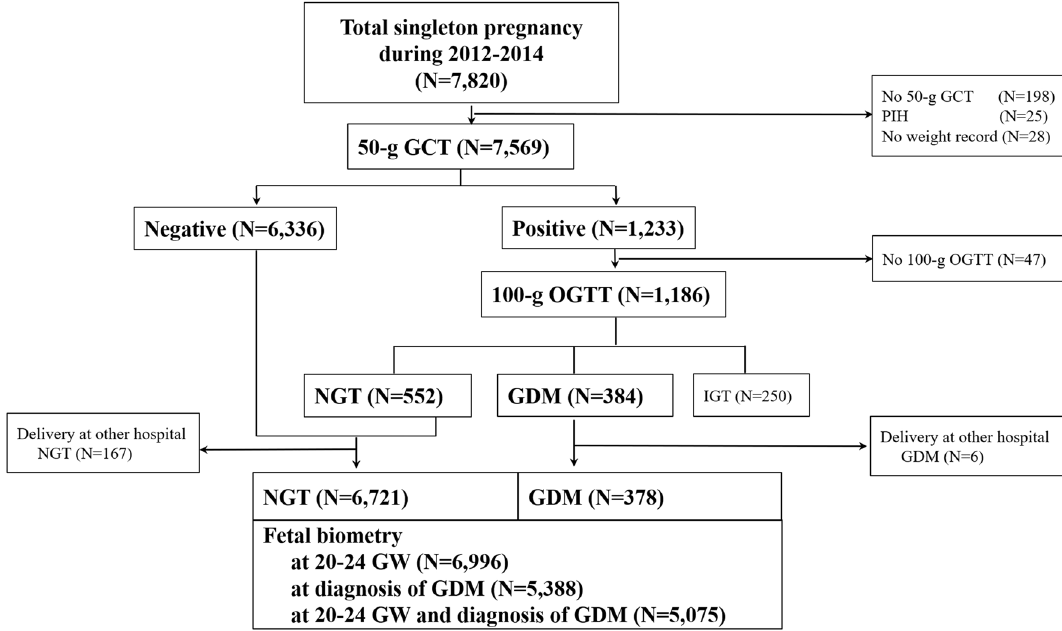
Figure 1. Study flow gram. GCT glucose challenge test, PIH pregnancy induced hypertension, OGTT oral glucose tolerance test, NGT normal glucose tolerance, GDM gestational diabetes mellitus, IGT impaired glucose tolerance, GW gestational